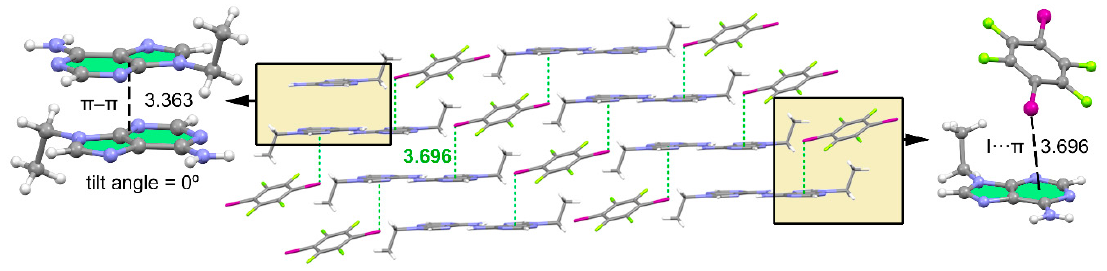
Figure 4. Partial view of the X-ray structure of 1 (middle) with indication of the π – π stacking (left) and lp– π interaction (right). Distances in Å. The π – π distance is measured between the mean planes of the adenine rings, which are parallel. The lp– π distance is measured from iodine to the ring centroid of the six-membered ring.